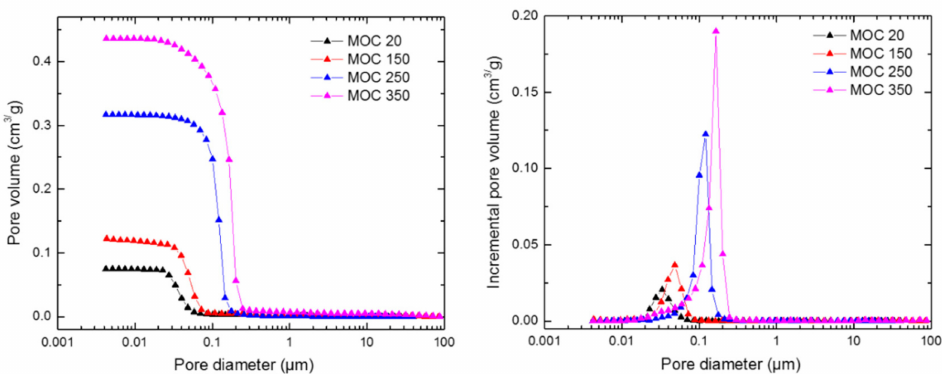
Figure 9. Pore size distribution of MOC 5-1-8 phase samples exposed to selected temperatures— cumulative curve ( left ) and increment pore volume ( right